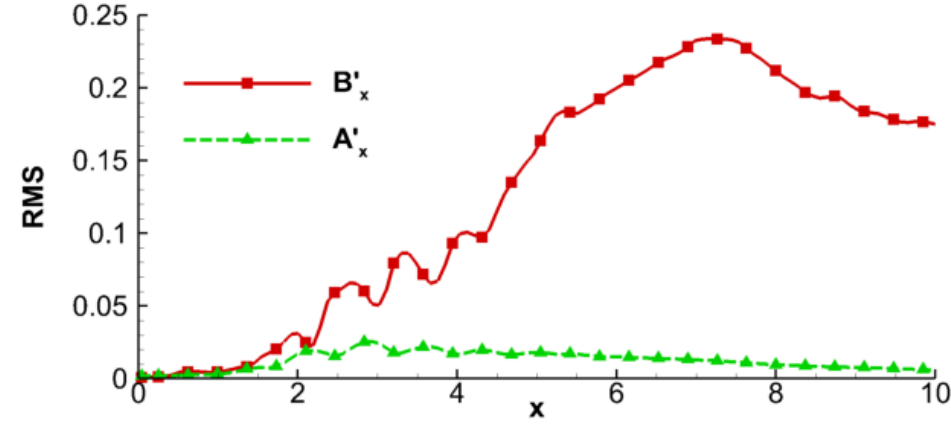
Figure 5. RMS of the hydrodynamic and acoustic modes along the centerline of the